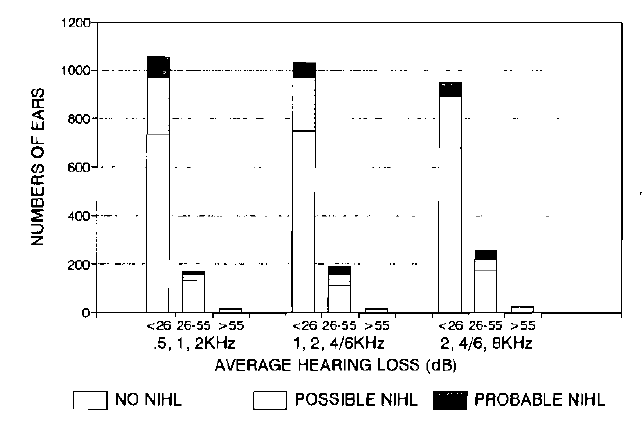
Figure 1. Noise-induced hearing loss (NIHL) com- ponent and severity of three-frequency-average hearing loss (<26 dB, 26-55 dB, and > 55 dB), for three different